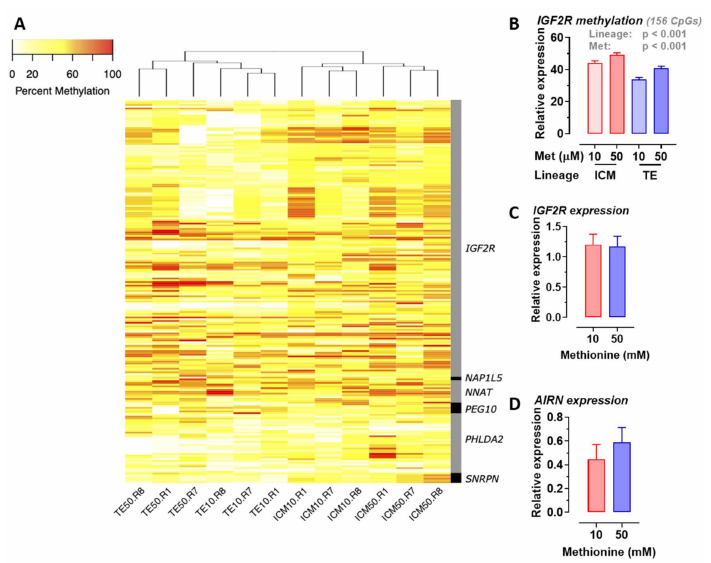
Figure 6. Effect of added methionine (50 v 10 µ M) during in vitro oocyte maturation and embryo culture on ( A ) heat map of CpG methylation for six imprinted genes (paternally expressed 10, PEG10 ; nucleosome assembly protein 1 like 5, NAP1L5 ; insulin like growth factor 2 receptor, IGF2R ; neuronatin, NNAT ; small nuclear ribonucleoprotein polypeptide N, SNRPN ; pleckstrin homology like domain family A member 2, PHLDA2 ) within the two primary cell lineages (inner-cell mass (ICM), and trophectoderm (TE)) of Day 8 bovine blastocysts; ( B ) CpG methylation of IGF2R at the two methionine concentrations within ICM and TE lineages; and transcript expression for IGF2R ( C ) and AIRN ( D ) in whole